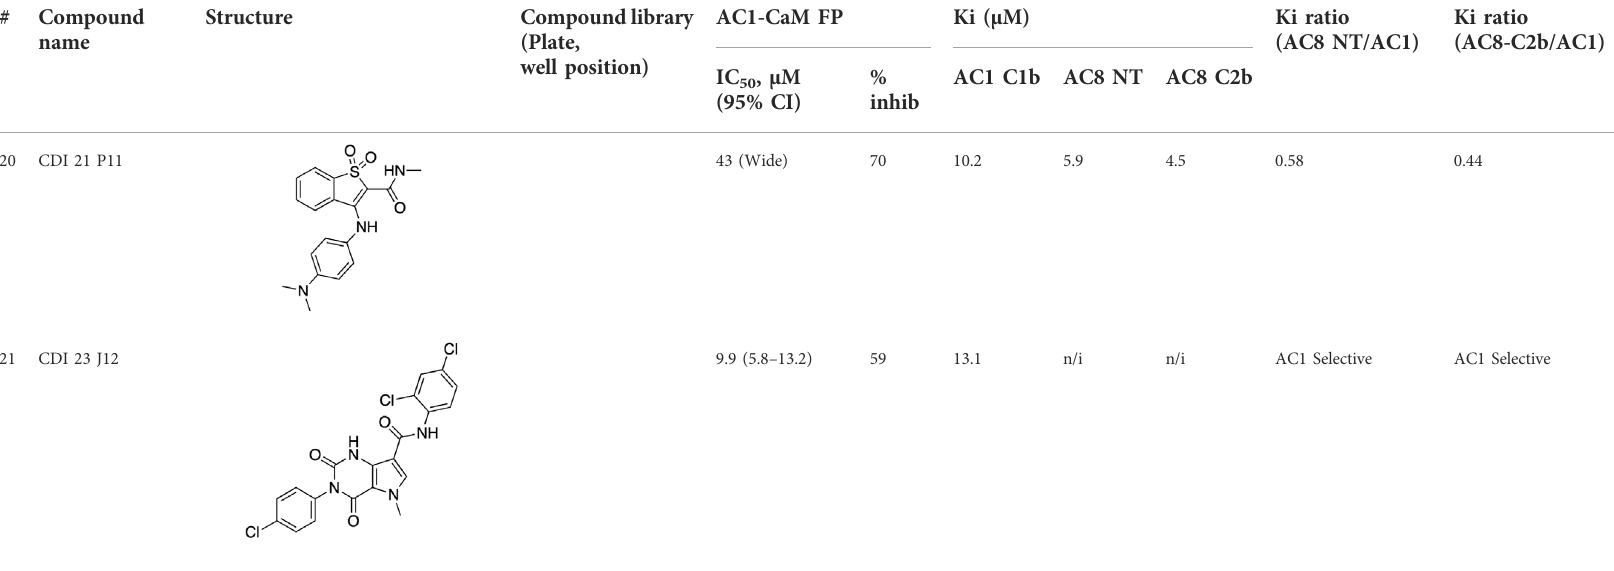
D values for each AC/CaM FP assay and the IC 50 values obtained for each compound in the designated AC/CaM FP assay. The either AC8-Nt/CaM or AC8-C2b/CaM over AC1/CaM. Values with K i ratios greater than 1 were more potent in the AC1/CaM FP assay over the designated AC8/CaM FP assay. All data represents n = 3 experiments, ± CI for AC1/CaM IC 50